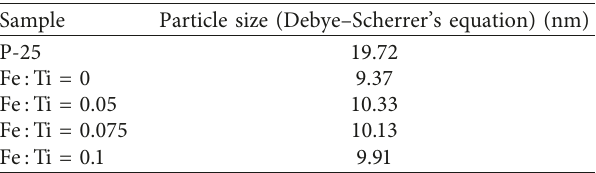
Figure 3: XRD spectra of TiO molar ratio calcined at 550 ° C for 3h. Table 2: Particle size obtained for the diameter by Debye– Scherrer’s equation.